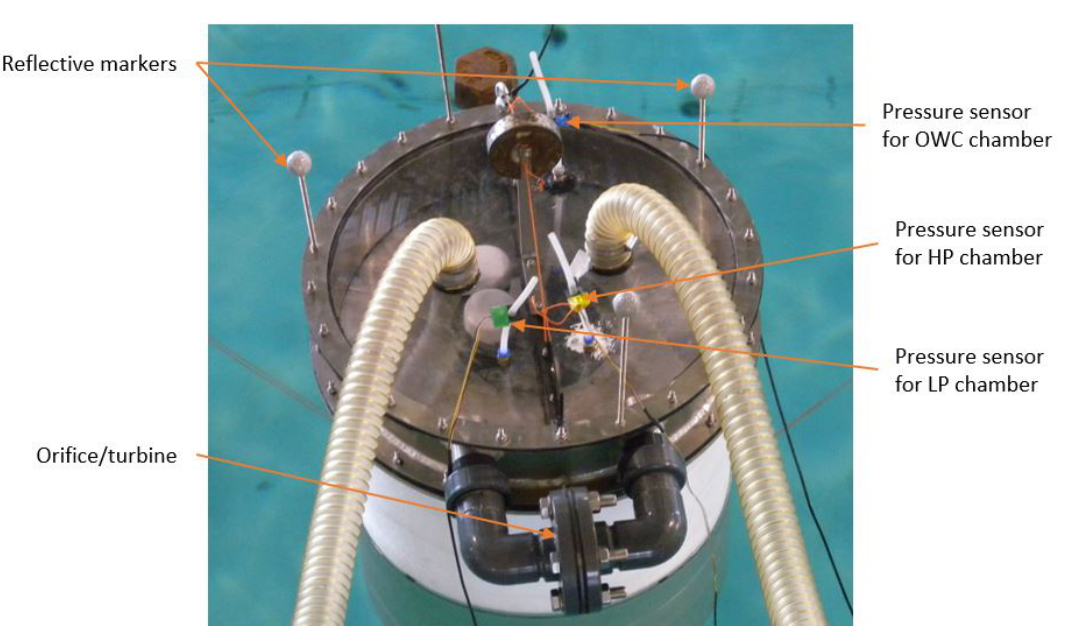
Figure 10. Top view of the Tupperwave